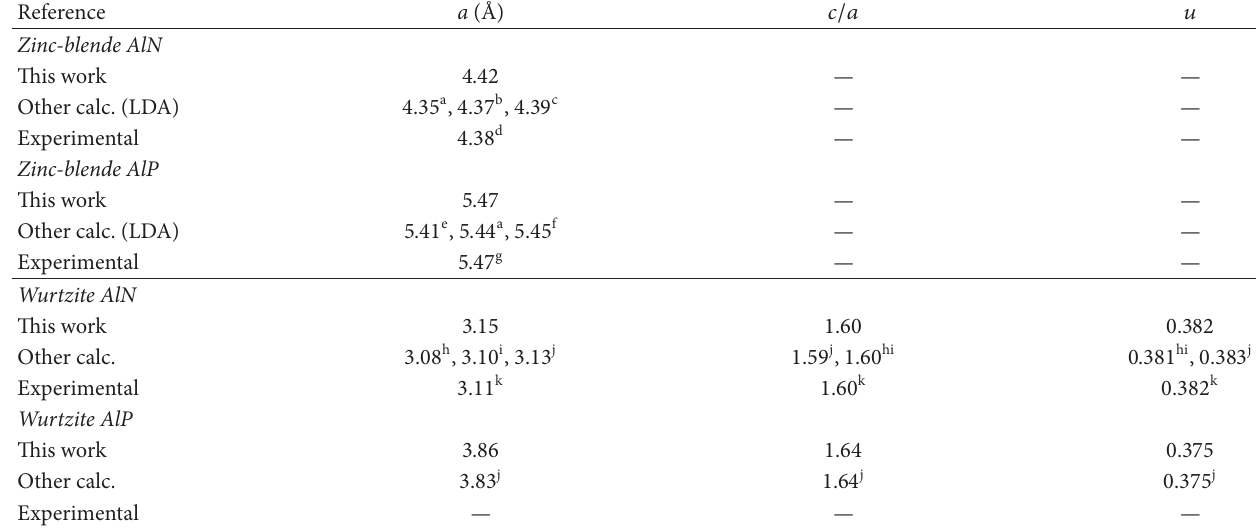
Table 1: Calculated lattice parameters a of AlN and AlP in ZB and WZ structures, 𝑐/𝑎 ratio, and the internal parameter u in WZ structure.